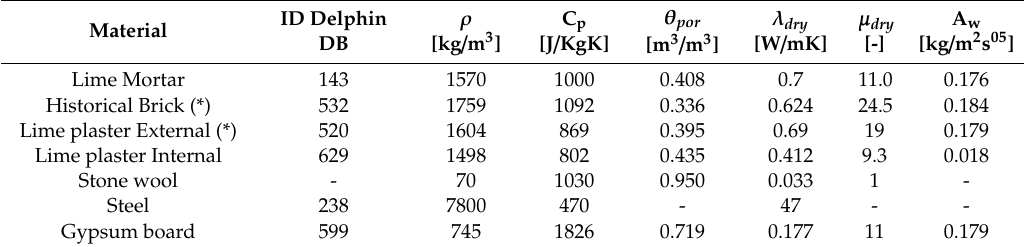
Table 2. Main hygrothermal properties of the chosen materials.